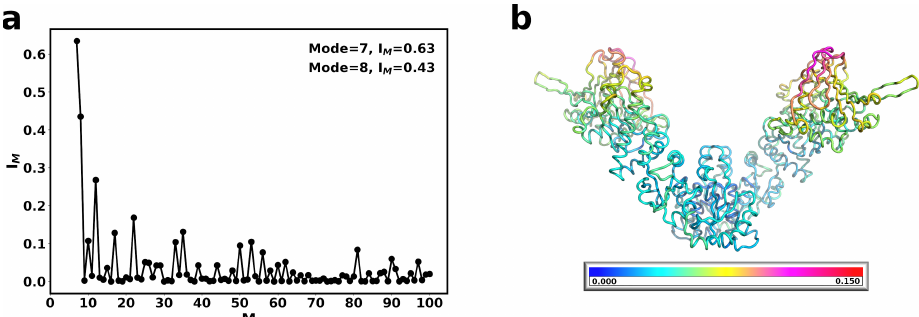
Figure 2. Normal modes of apo Hsp90 Ec ( a ) Structural overlap of the normal modes of apo Hsp90 Ec with ADP bound Hsp90 Ec to identify the modes that contribute to the biological movement. The closed circles represent the overlap for individual modes. Lines are drawn for clarity. Nonzero modes with the highest structural overlap are considered. ( b ) The sum of the individual amino acid fluctuations in both modes 7 and 8 are represented on the structure of Hsp90 Ec . Blue represents static residues while red highlights highly mobile residues.